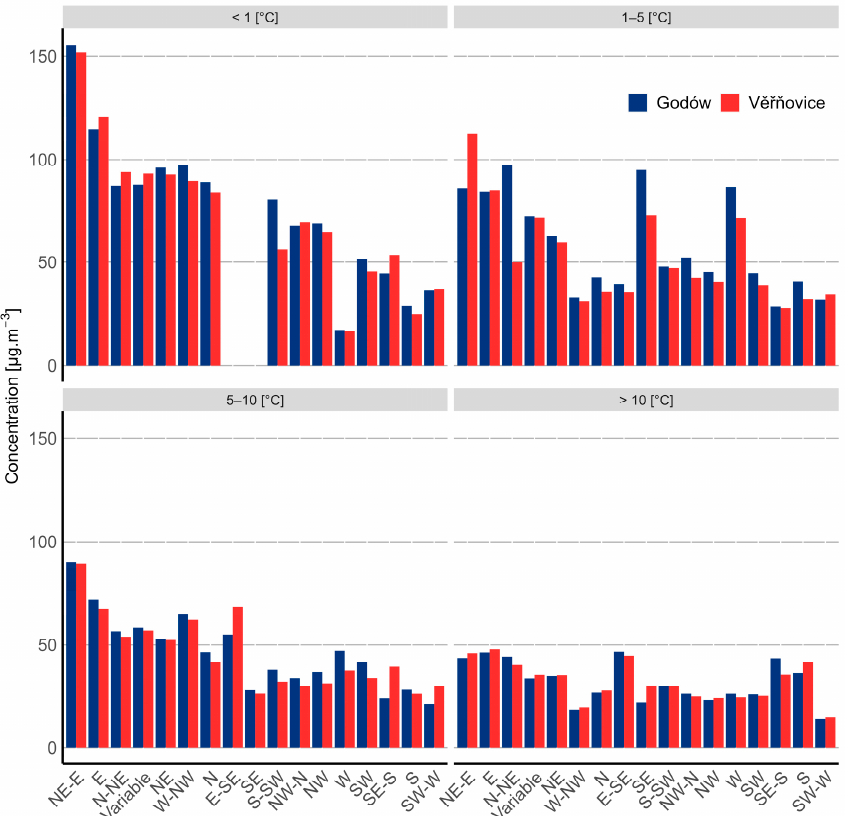
Figure 12. Average PM 10 concentrations by individual daily types of wind and temperature, V ěřň ov- ice and Godów site, 2011–2020.